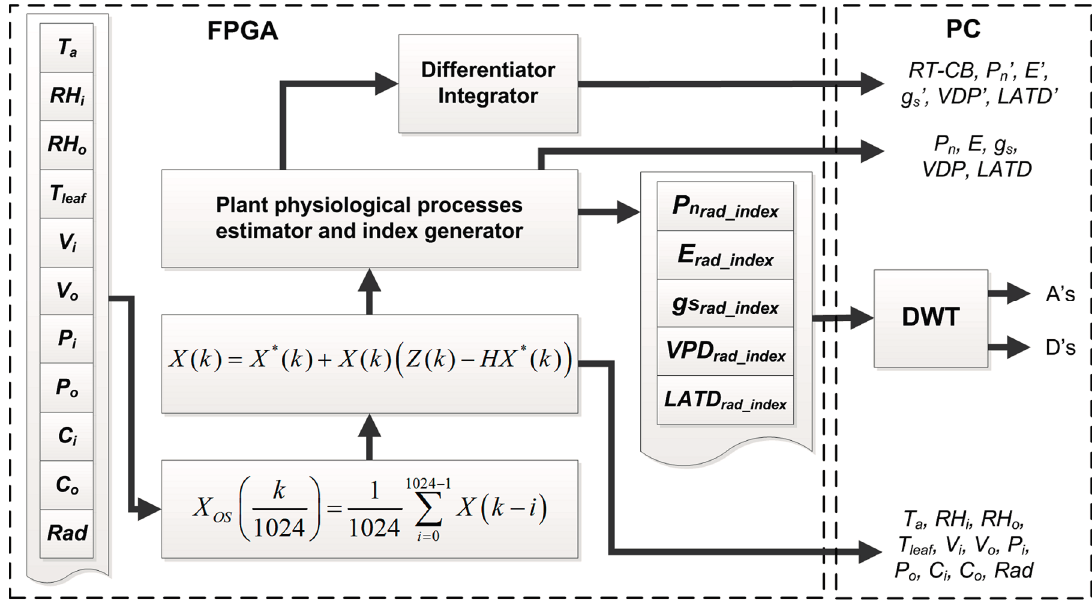
Figure 3. FPGA filtering stage and plant physiological estimator